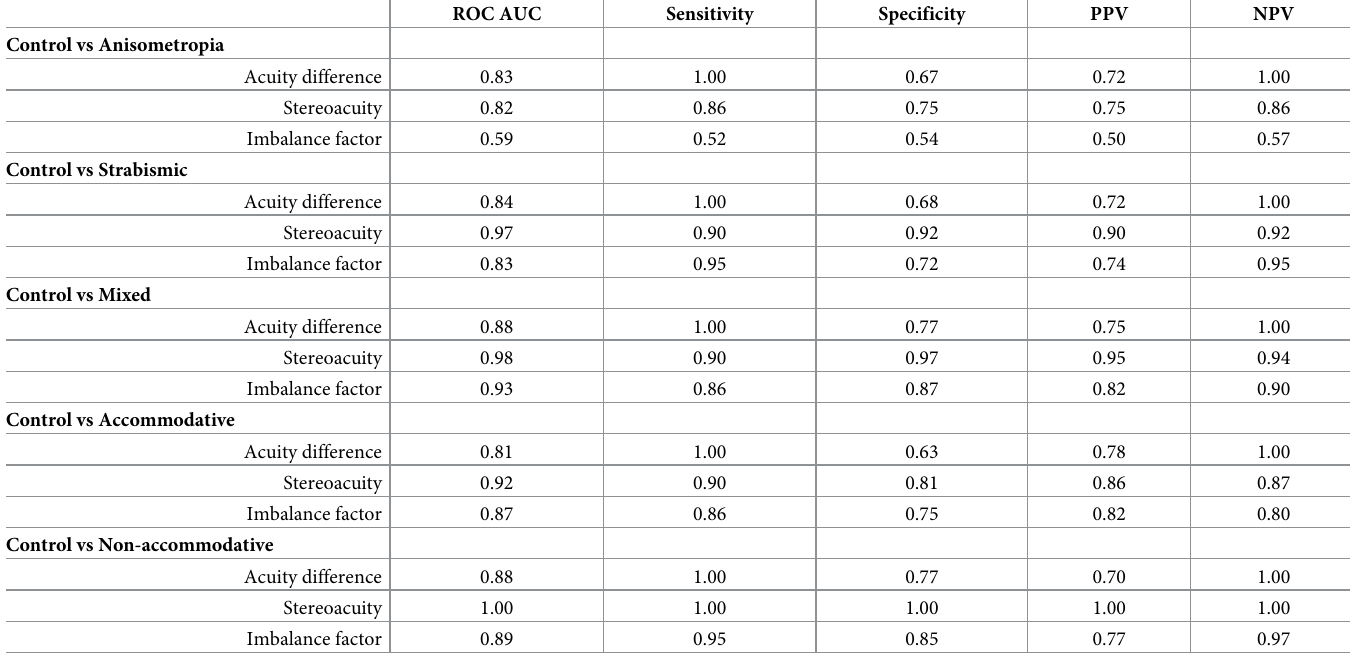
Table 5. Univariate logistic classification models. Results obtained by three different models, based on acuity difference, stereoacuity and imbalance factor, when differ- entiating control group from others: amblyogenic factor (anisometropia, strabismus or mixed) and refractive response (accommodative or non-accommodative). ROC